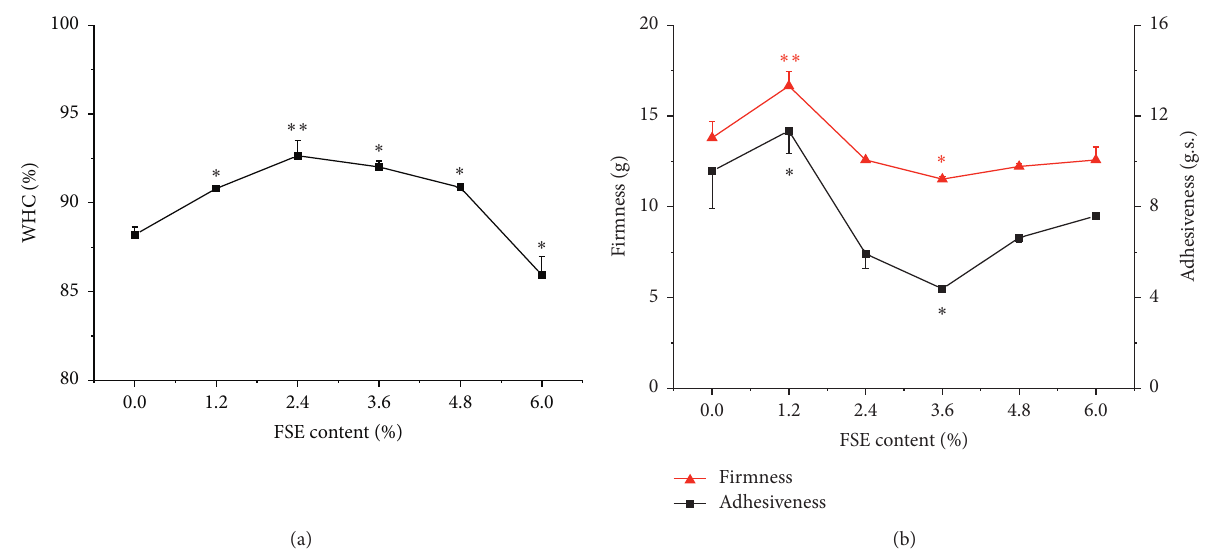
Figure 2: Effect of supplementing different concentrations of FSE on WHC (a) and textural properties (b) of yogurts. ∗ Significant difference at p < 0 . 05; ∗∗ significant difference at p < 0 . 01 compared with Con. FSE: Flos Sophorae extract; WHC: water holding capacity.